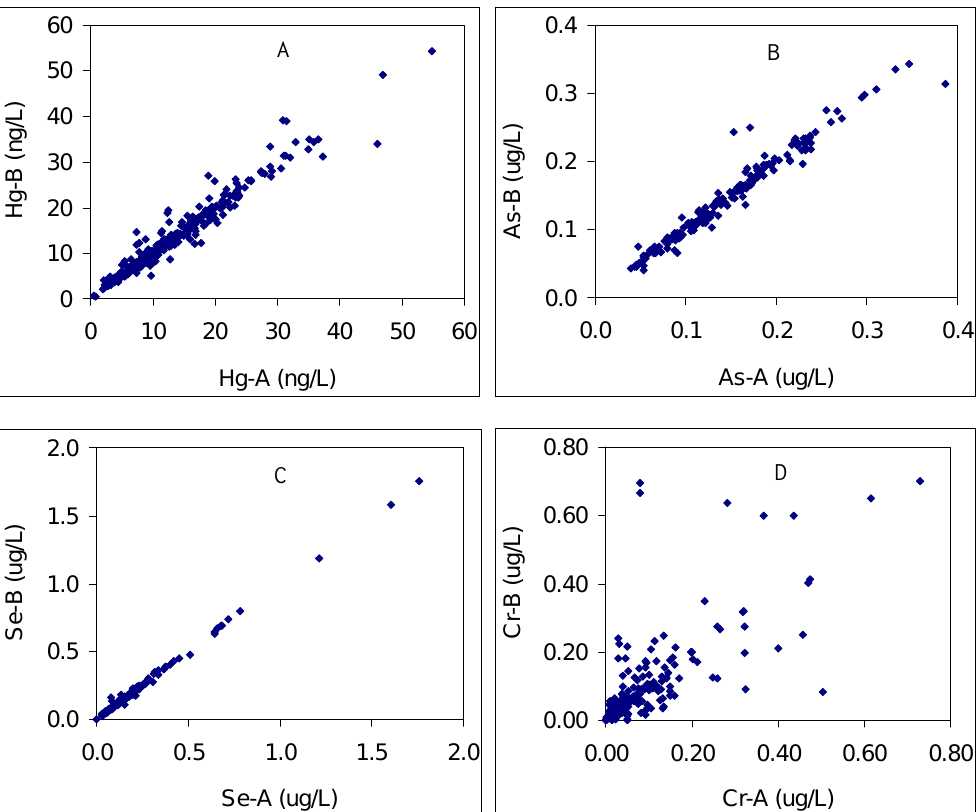
Fig. 3. Comparison of analyses of duplicate (A vs. B) rain samples. Mercury (A) , arsenic (B) , and selenium (C) all show excellent agreement with data well above the detection limits. Chromium (D) shows greater scatter due to concentrations closer to the detection